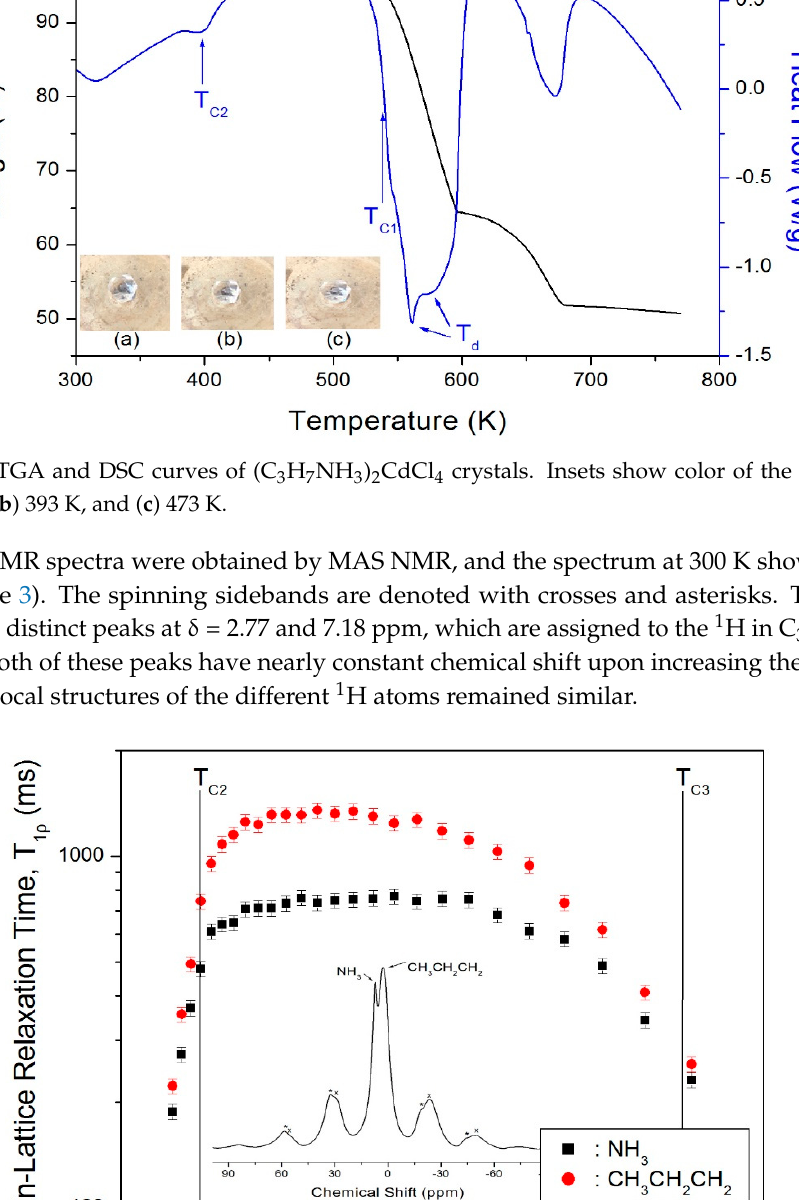
Figure 4. 13 C CP/MAS NMR spectrum of (CH 3 CH 2 CH 2 NH 3 ) 2 CdCl 4 at 300 K.